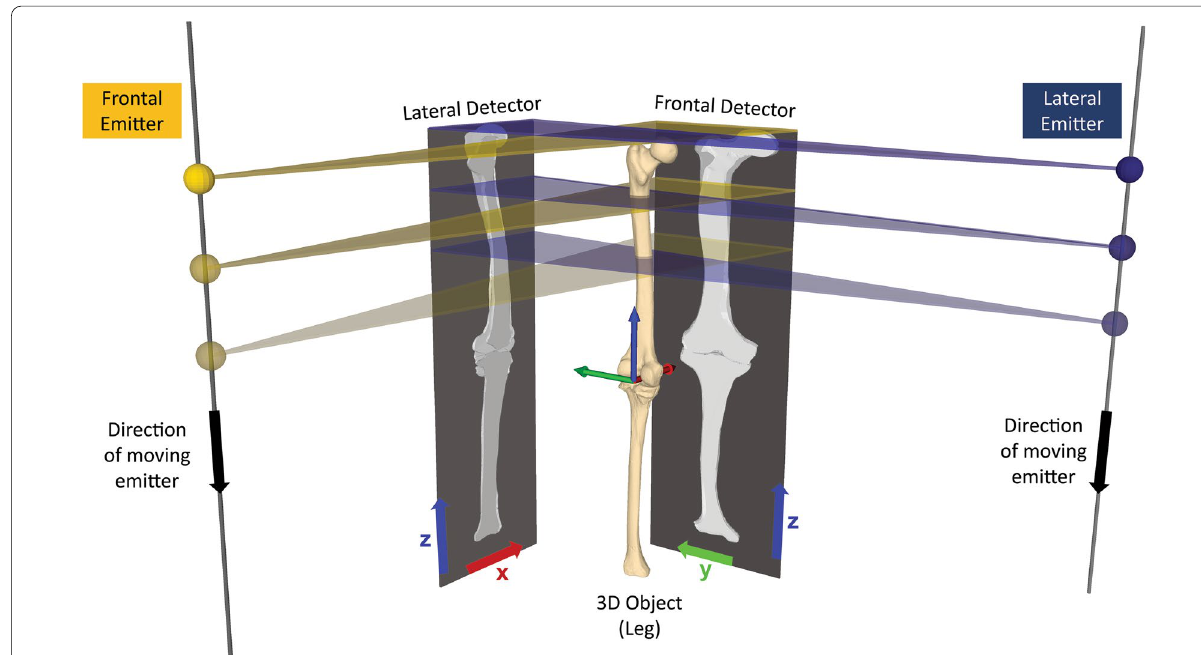
Fig. 2 Geometry of the EOS System. The EOS imaging systems produces biplanar long-leg standing X-rays by using a fan-beam scan approach, in which only the horizontal axis of the image is affected by projective effects. Frontal (in yellow) and lateral (in blue) emitters are depicted as spherical sources. The emitters move synchronously along the z-axis (shown in green). The vertical y-axes of the lateral and frontal detectors directly relate, without magnification, to the z-axis in the EOS coordinate